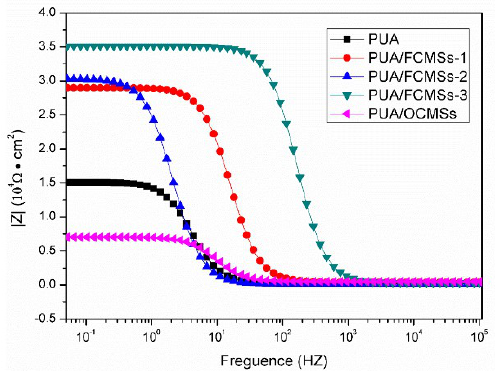
Figure 15. Bode spectrum of UV-curable polyurethane composite coatings.